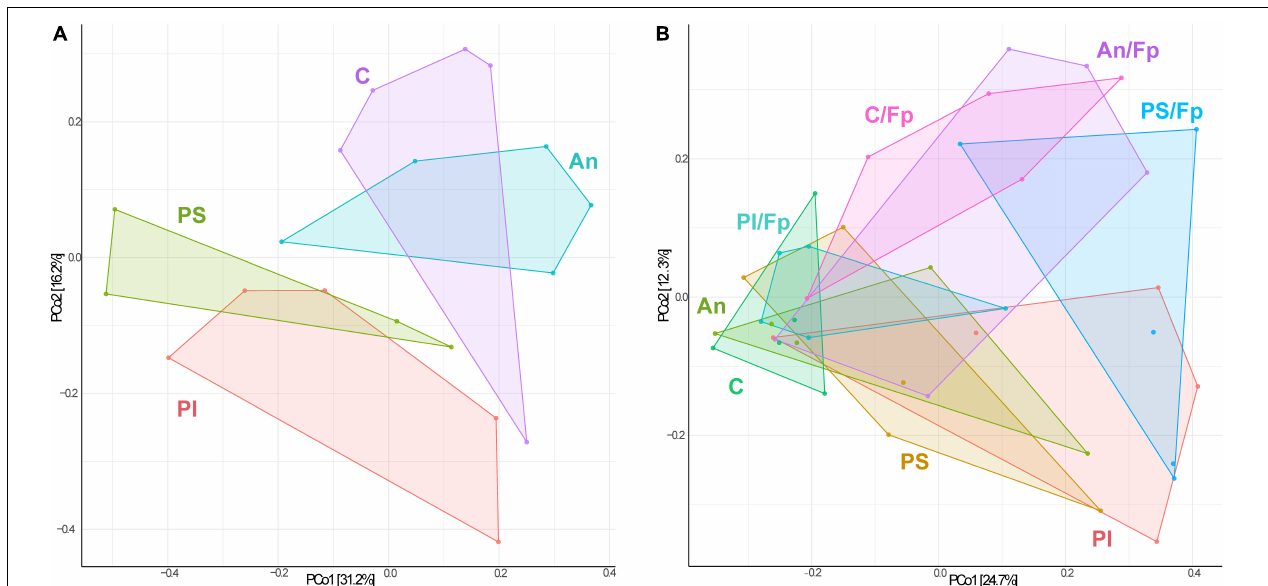
FIGURE 4 | Principal Coordinates Analysis (PCoA) 1 day before ( A , 19 samples and 423 OTUs) and 1 day after ( B , 40 samples and 478 OTUs) the infection [The OTUs were transformed to relative abundance]. Prior to the analysis, OTU’s that are not present in more than 0.1% relative abundance in any sample have been removed. No initial data transformation has been applied. The relative contribution (eigenvalue) of each axis to the total inertia in the data is indicated in percent at the axis titles. C, control feed group; An, antibiotic feed group; PI, phage-immobilized feed group; PS, phage-sprayed feed group; C/Fp, control feed group + F. psychrophilum ; An/Fp, antibiotic feed group + F. psychrophilum ; PI/Fp, phage-immobilized feed group + F. psychrophilum ; PS/Fp, phage-sprayed feed group + F. psychrophilum